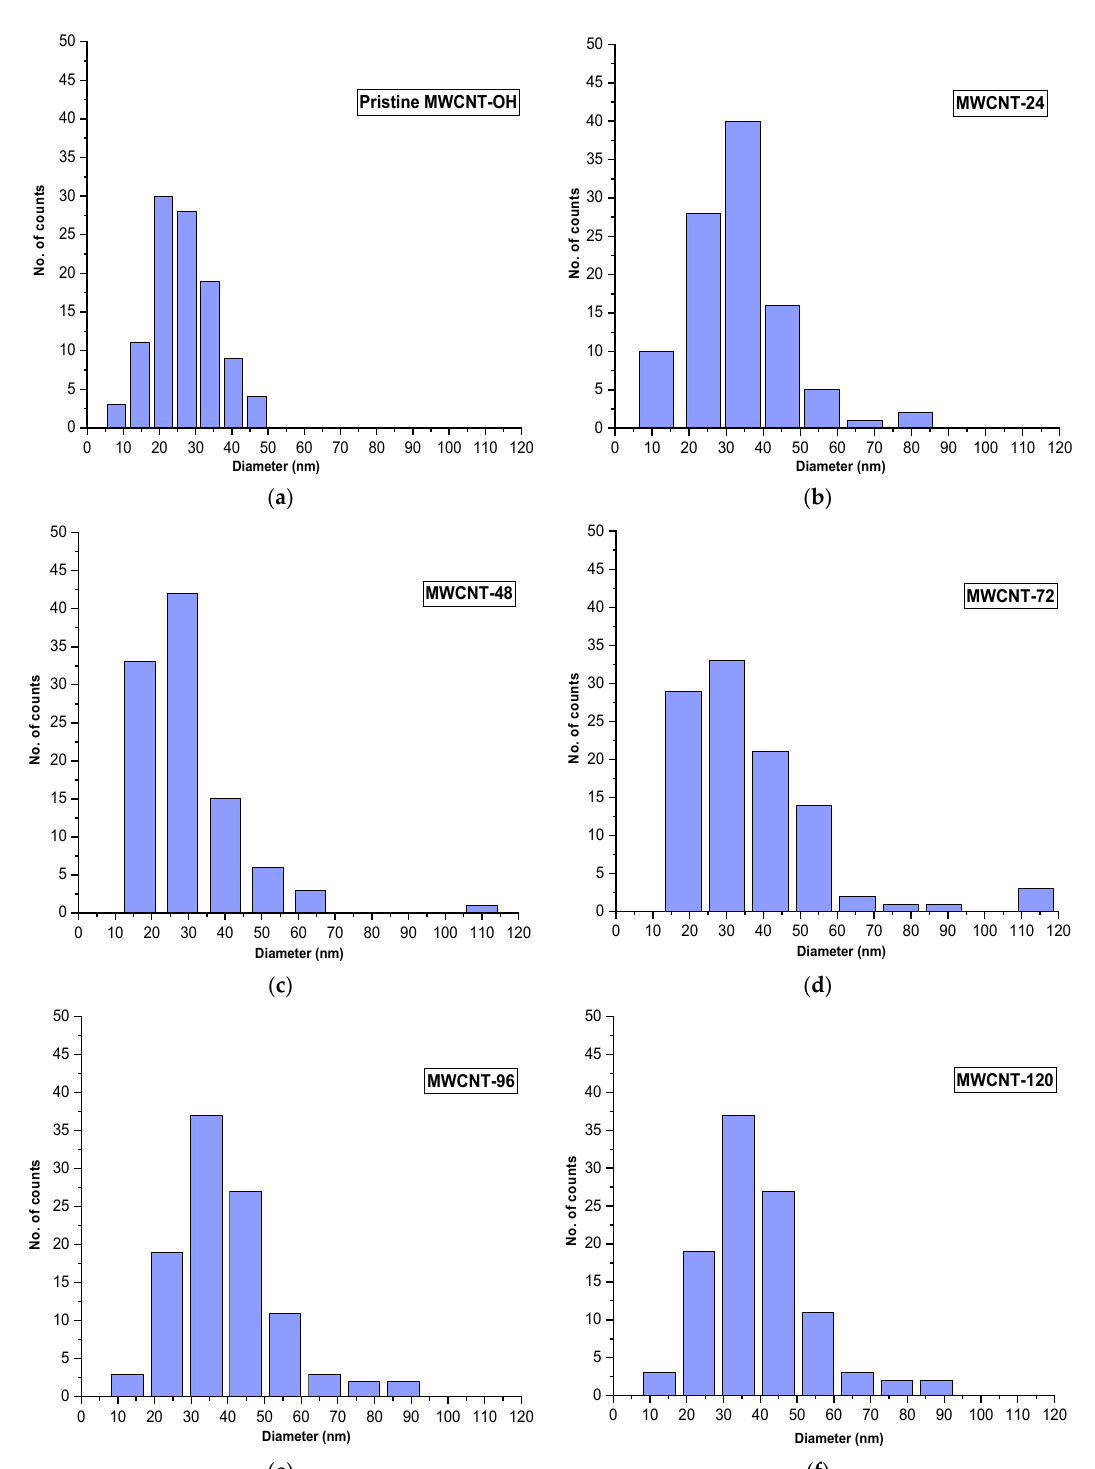
Figure 5. Histogram of diameter size distribution of ( a ) pristine MWCNT-OH and ( b – f ) P3HT/MWCNT-OH nanocompo- sites at different reaction times.